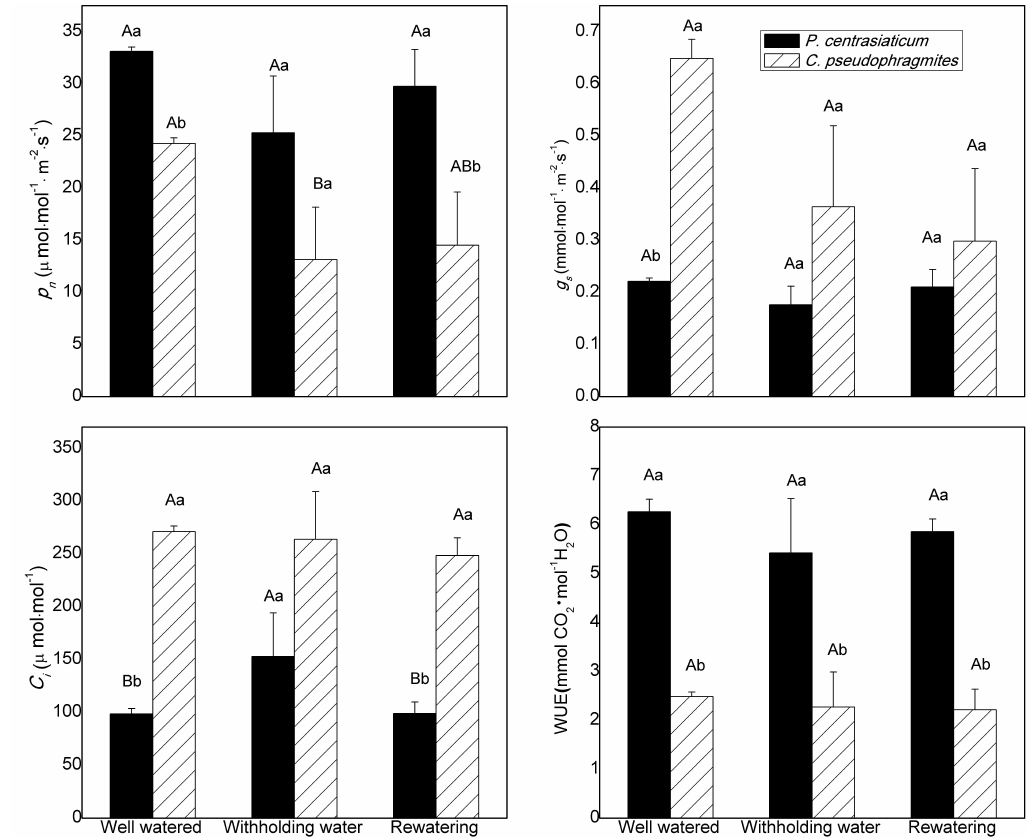
Figure 2. Changes in leaf net photosynthetic rate ( P n ), stomatal conductance ( g s ), intercellular CO 2 concentration ( C i ) and water use e ffi ciency (WUE) during soil drought and rewatering for P. centrasiaticum (C 4 ) and C. pseudophragmites (C 3 ), respectively. Drought-stressed treatment is divided into two periods, namely, withholding water period and rewatering period. There were ten, six and four days of measurement for well-watered, withholding water and rewatering, respectively. Di ff erences among well-watered, withholding water period, and rewatering period were marked with capital letters for each species. Di ff erences between the two species were marked with lowercase letters. Values are means ±